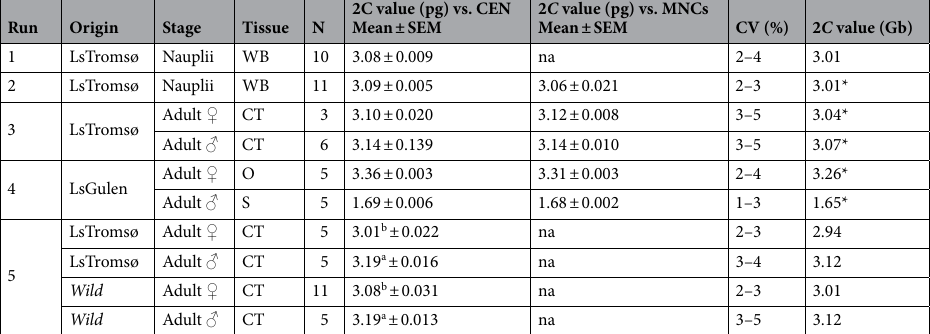
Table 3. Nuclear DNA contents of somatic and gametic cells of L. salmonis salmonis as measured using flow cytometry. Runs 1, 2, 3, and 5 measured somatic cells of nauplii or adults of the LsTromsø strain. Run 4 measured gametic cells of the Ls Gulen laboratory strain. Run 5 compared the laboratory reared LsTromsø strain to wild caught adults from naturally infected fish reared in Tromsø. Chicken and/or human white blood cells were used as internal reference standards. CEN Chicken erythrocyte nuclei (2 C value = 2.5 pg DNA per nucleus), MNCs human mono-nucleated cells (2C value = 7.0 pg DNA per nucleus), WB whole body, CT cuticular and subcuticular tissues from cephalic region, O oocytes, S sperm, N number of individuals or number of samples in the cases of nauplii analyzed, CV coefficient of variation as a percentage of mean for target nuclei ( L. salmonis data), Na not available. For naupliar stages (run 1 and 2), each sample consisted of approximately 50 nauplii. *Average value based on the two internal standards. For Run 5, 2C values with superscripts “a” and “b” differ at P < 0.05 (two-way